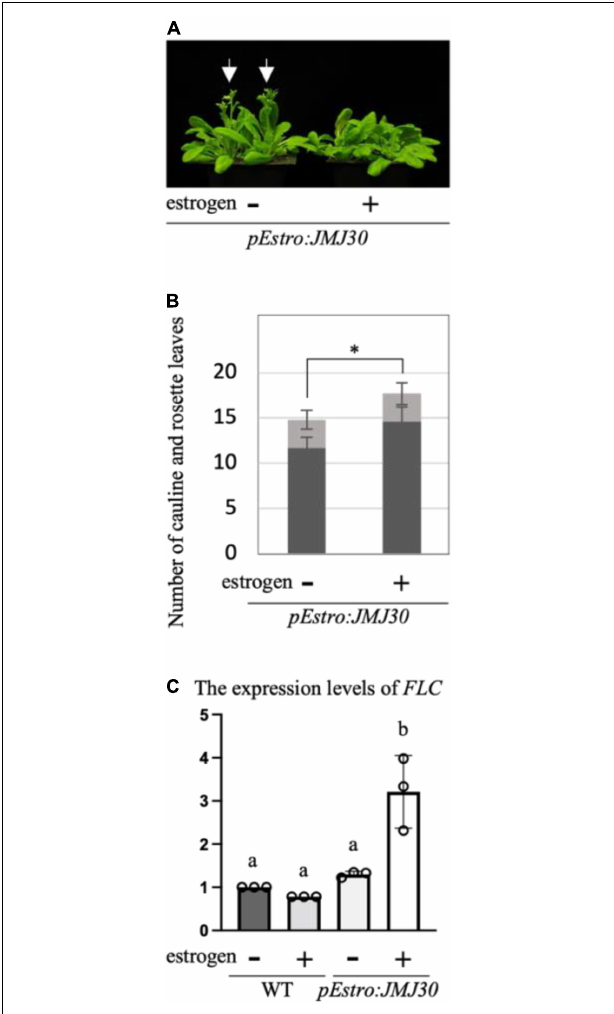
FIGURE 4 | Overexpression of JMJ30 conferred the late flowering phenotype. (A) Photograph of pEstro:JMJ30 treated without (left) and with (right) estrogen. Arrows indicate the flowers. (B) Quantification of the number of cauline (gray) and rosette (black) leaves of pEstro:JMJ30 treated without (left) and with (right) estrogen. Error bars represent SD. ∗ p < 0.05 (Student’s t -test). (C) Quantification of the expression levels of FLC in wild-type and pEstro:JMJ30 treated without (left) and with (right) estrogen. Error bars represent SD. One-way ANOVA followed by the Tukey–Kramer test was performed ( p < 0.05). Different letters indicate significant differences, while the same letters indicate non-significant differences. Note that estrogen treatments did not alter the expression levels of FLC in the wild type; however, in pEstro:JMJ30 , the same treatments upregulated the expression levels of FLC .